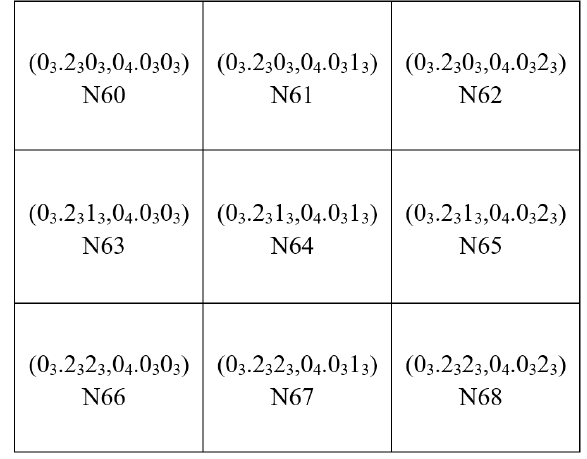
Figure 2. Adjacent cells of cell N 64 expressed using 𝑟𝑜𝑤, 𝑐𝑜𝑙𝑢𝑚𝑛 notation and cell IDs.